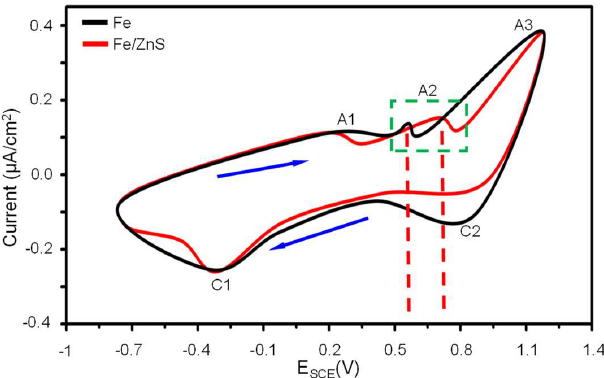
Figure 5. The cyclic voltammetry curves obtained from electrochemical tests.